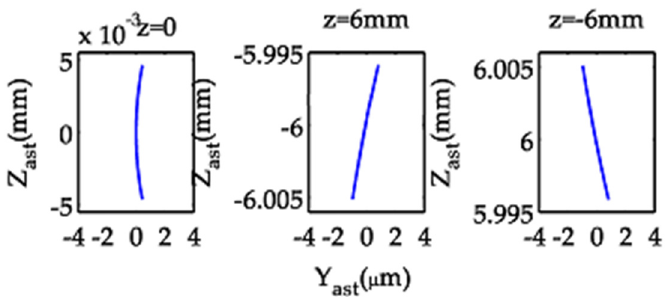
Figure 4. Astigmatic curves of the model optical system in the meridional focal plane.